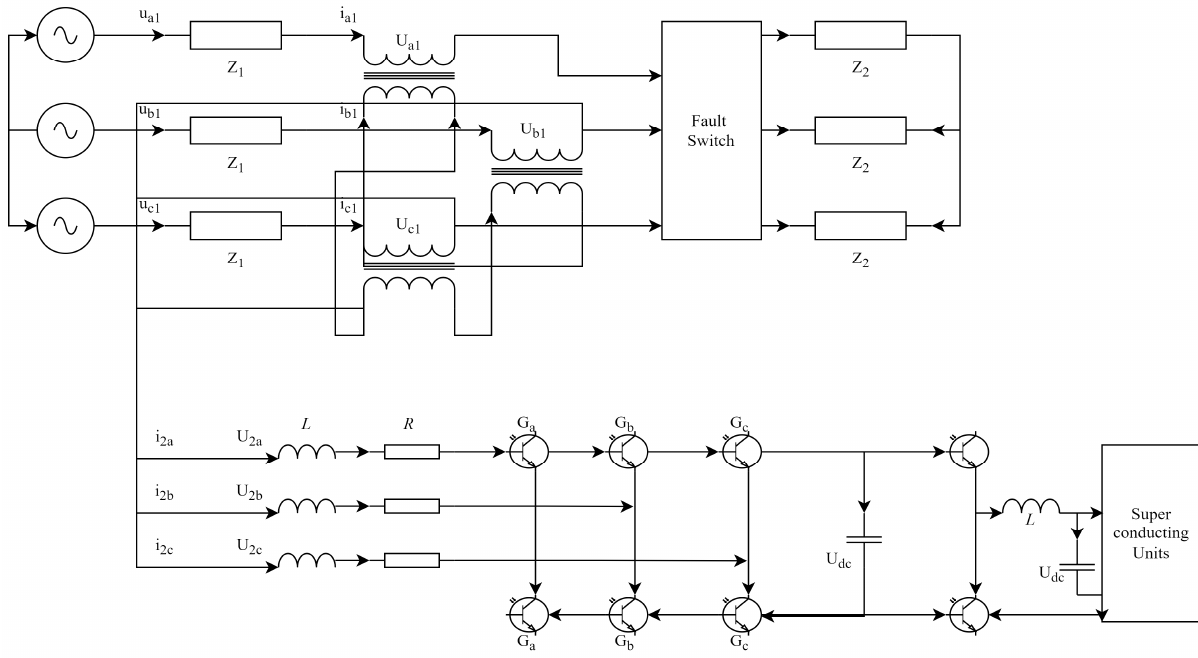
Figure 4. Electrical structure of SFCL.